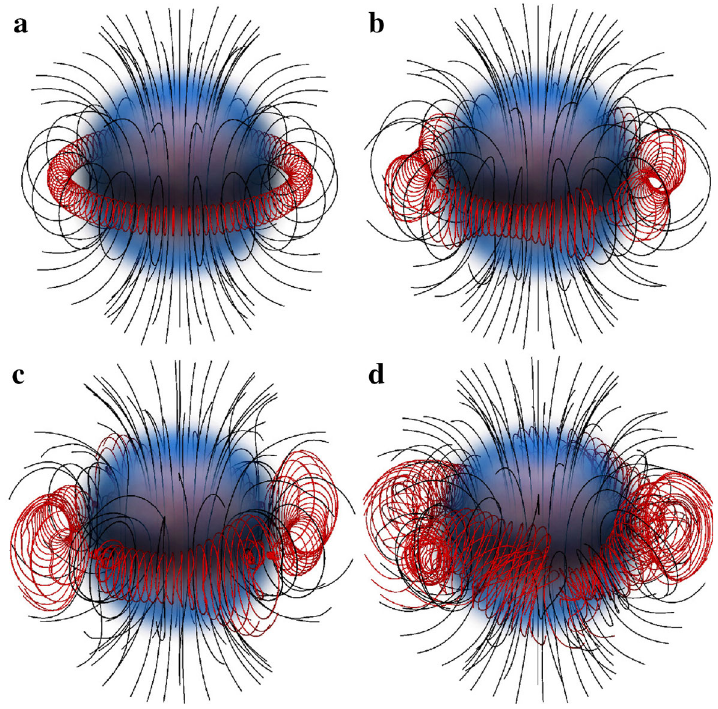
Fig. 38 Time evolution of a magnetized, rotating neutron star model with central magnetic field 10 17 G, initially rotating at 100 Hz with a polar to equatorial radius ratio of 0 . 99. Lines represent the magnetic field lines and the volume rendering the rest-mas density. The red field lines are seeded on the equatorial plane close to the neutral line, and the black field lines are seeded on the equatorial plane interior to the neutral line. The volume rendering is an contour surface at 37% of the central rest-mass density. The plots correspond to times a t = 0ms, b t = 17ms, c t = 27ms and d t = 42ms. (Image reproduced with permission from Lasky et al.